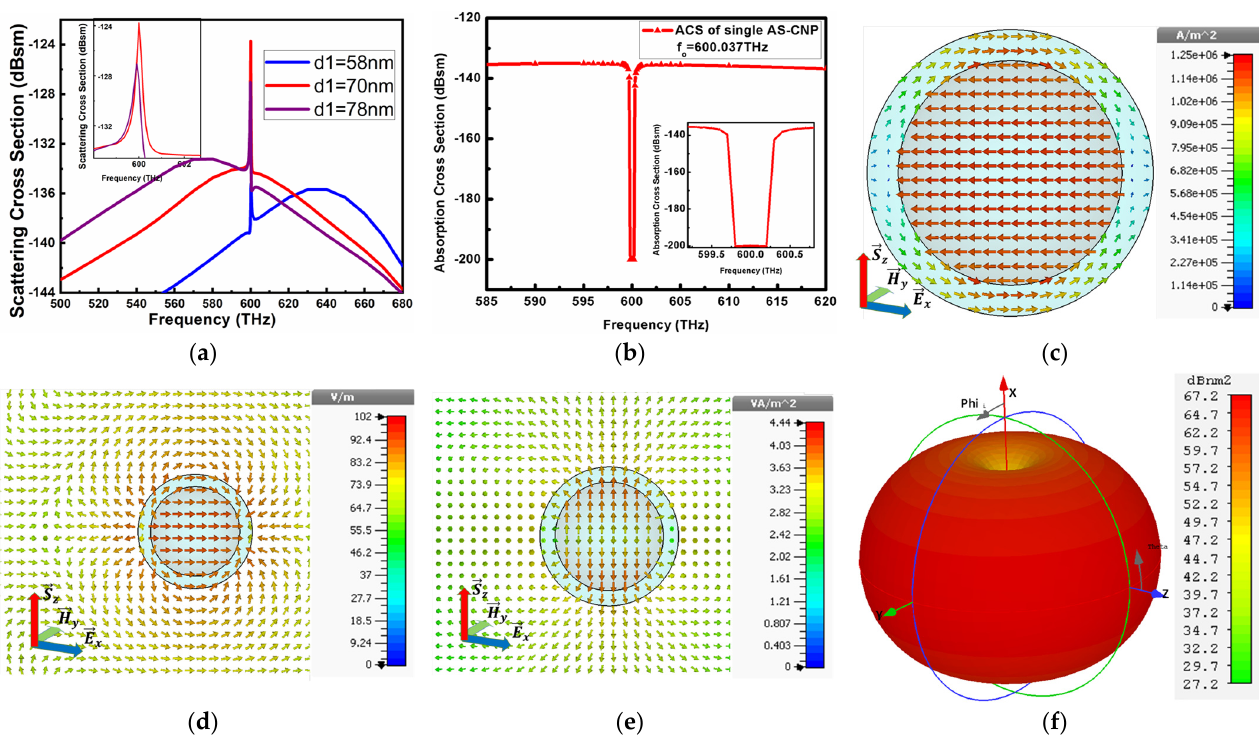
Figure 2. ( a ) SCS peak, ( b ) ACS value, ( c ) electric current density, ( d ) electric field pattern, ( e ) power flow pattern and ( f ) far-field pattern at resonance frequency for individual CNP model.